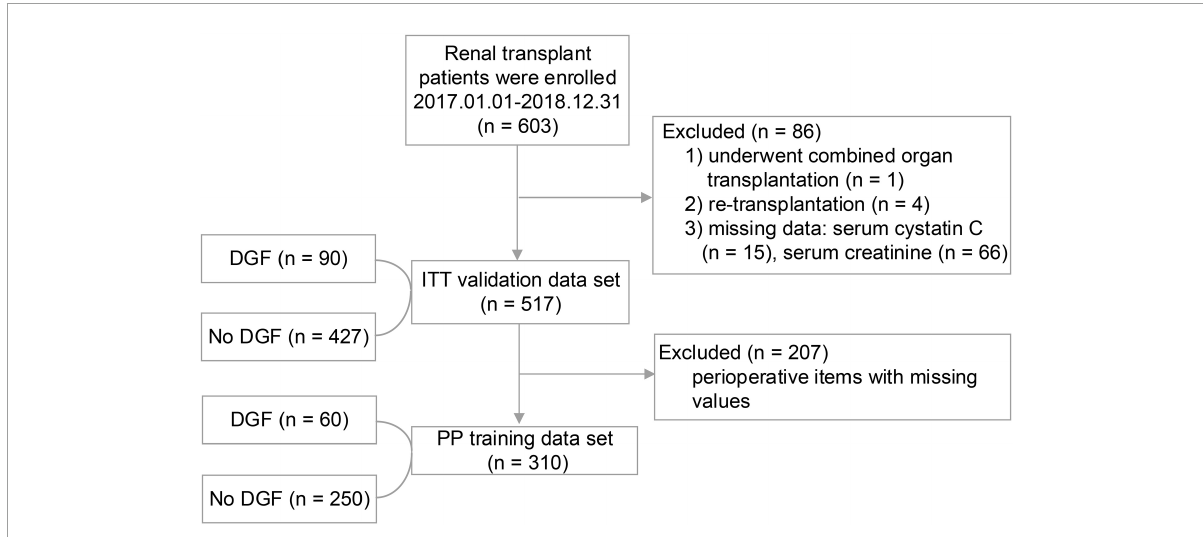
FIGURE1 The study flowchart. During the study period, 603 patients underwent renal transplant surgery. A total of 86 (14.26%) patients were excluded because they did not satisfy the inclusion criteria. In the end, a total of 517 (Intention-To-Treat set) first time renal transplant recipients were included in the study, of whom 207 were excluded from the Per-Protocol analysis.